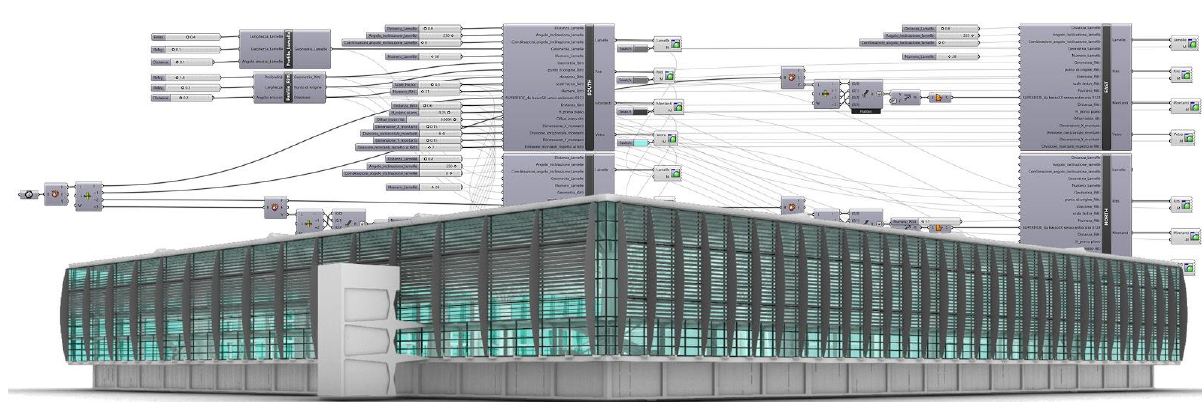
Figure 4: the merging of the algorithmic model of the curtainwall and the BIM model of the remaning part of the building. The south facade (on the right) re-proposes the current state, the west facade (on the left) demonstrates the potential of the code in